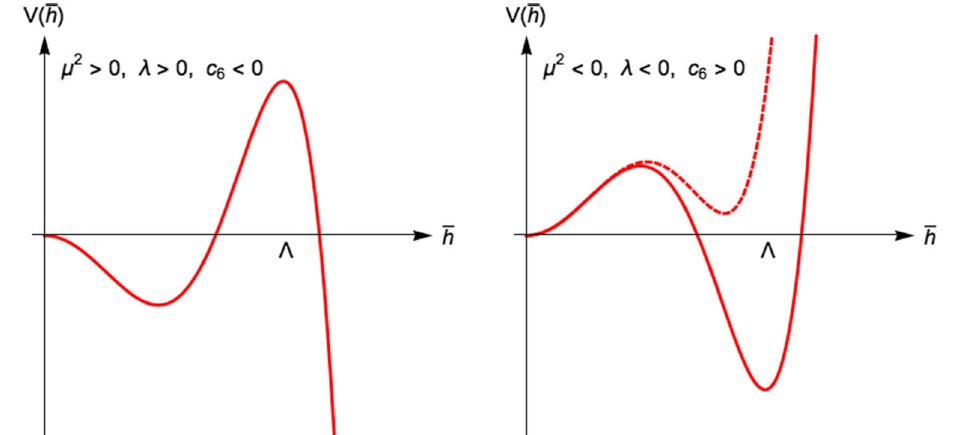
cutoff scale (cid:2) . For large enough c 6 > 0, the absolute minimum is in ¯ h = 0 (dashed line), and the EW vacuum gets